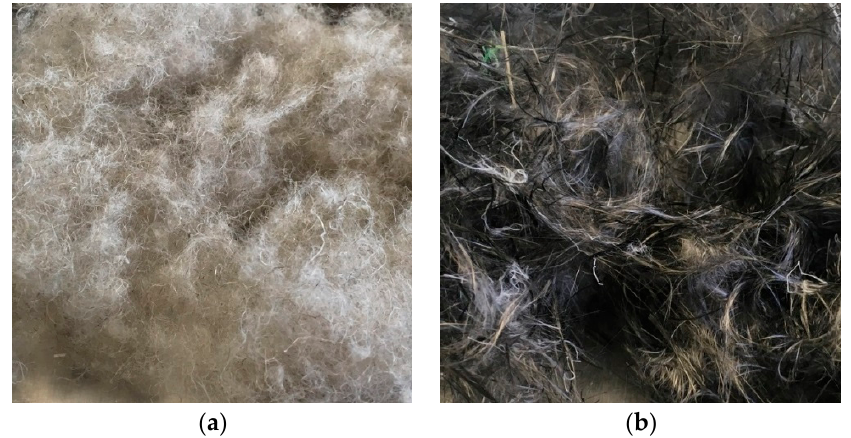
Figure 2. The delivery form of the fibres used for the assessment of hybrid nonwoven in this study. Flax fibres ( a ) and recycled carbon fibres ( b ).